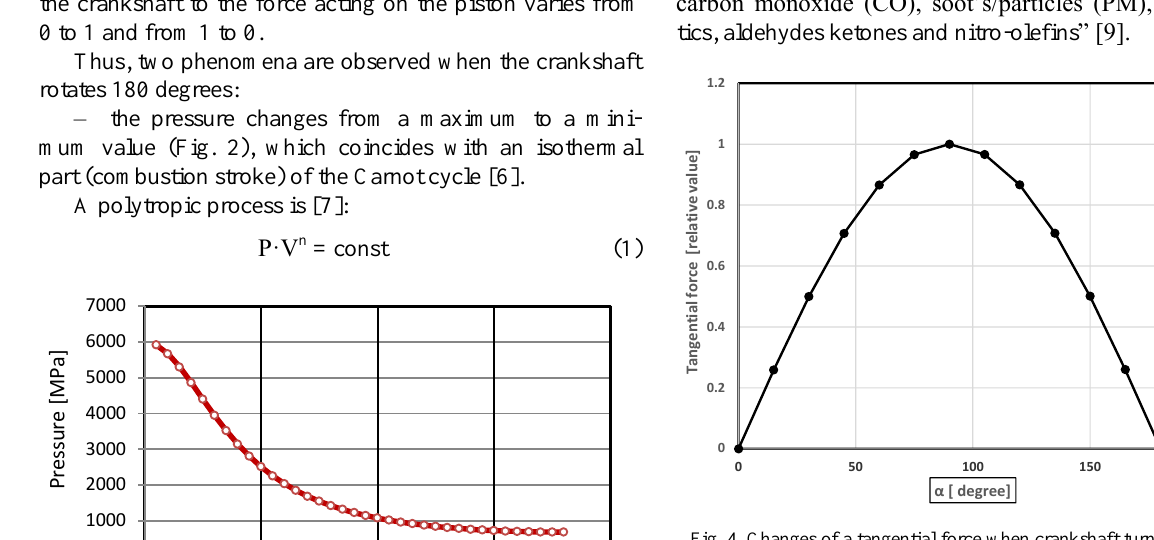
Fig. 4. Changes of a tangential force when crankshaft turns 180 degrees